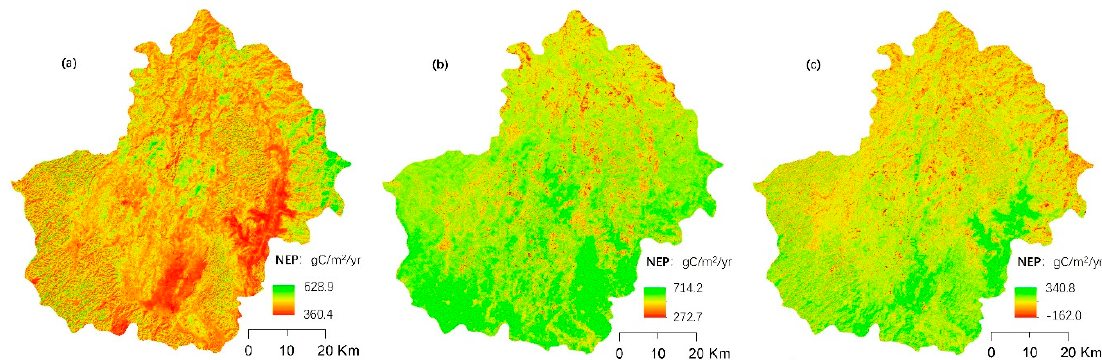
Figure 2. Spatial distribution of net ecosystem productivity (NEP) and its change in Huanjiang County. ( a ) The distribution of NEP in 2005; ( b ) the distribution of NEP in 2015; ( c ) the changes of NEP from 2005 to